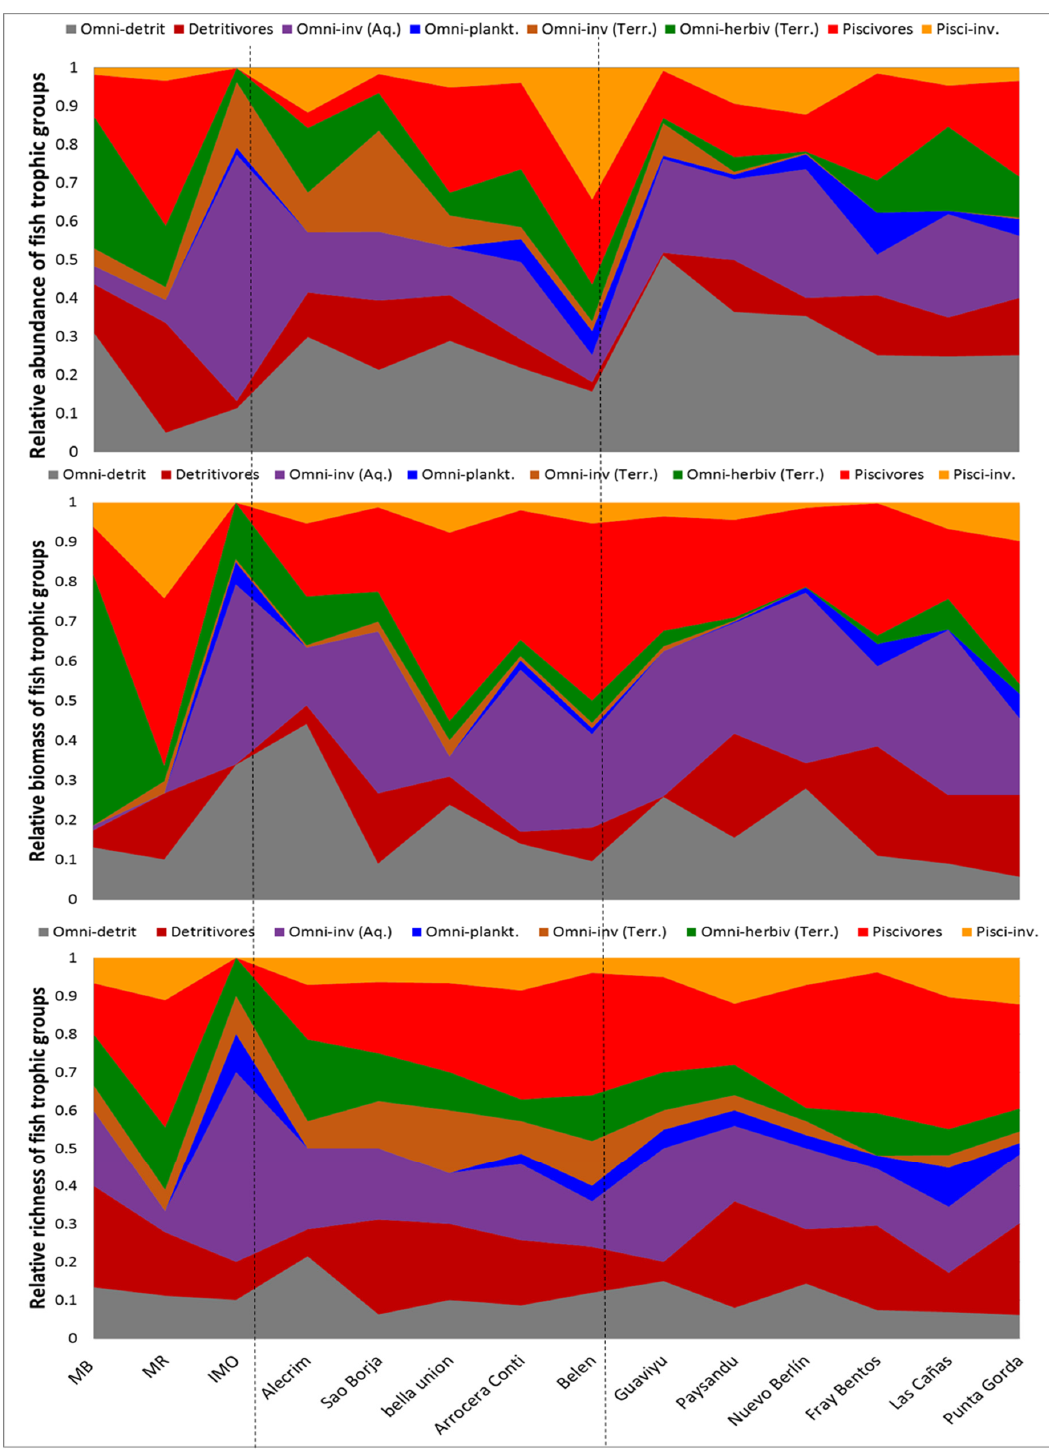
Figure 4. Longitudinal variability in trophic structure of the fish assemblages in sampled locations of Uruguay River from upper (MB, MR, IMO) to middle (Alecrim, Sao Borja, Bella Unión, Isla del Zapallo, Belén) and lower (Guaviyú, Paysandú, Nuevo Berlín, Fray Bentos, Las Cañas and Punta Gorda) river sections. Dashed lines represent the division between river sections. Above: Relative biomass; middle panel: Relative abundance; and below relative richness of each trophic group.